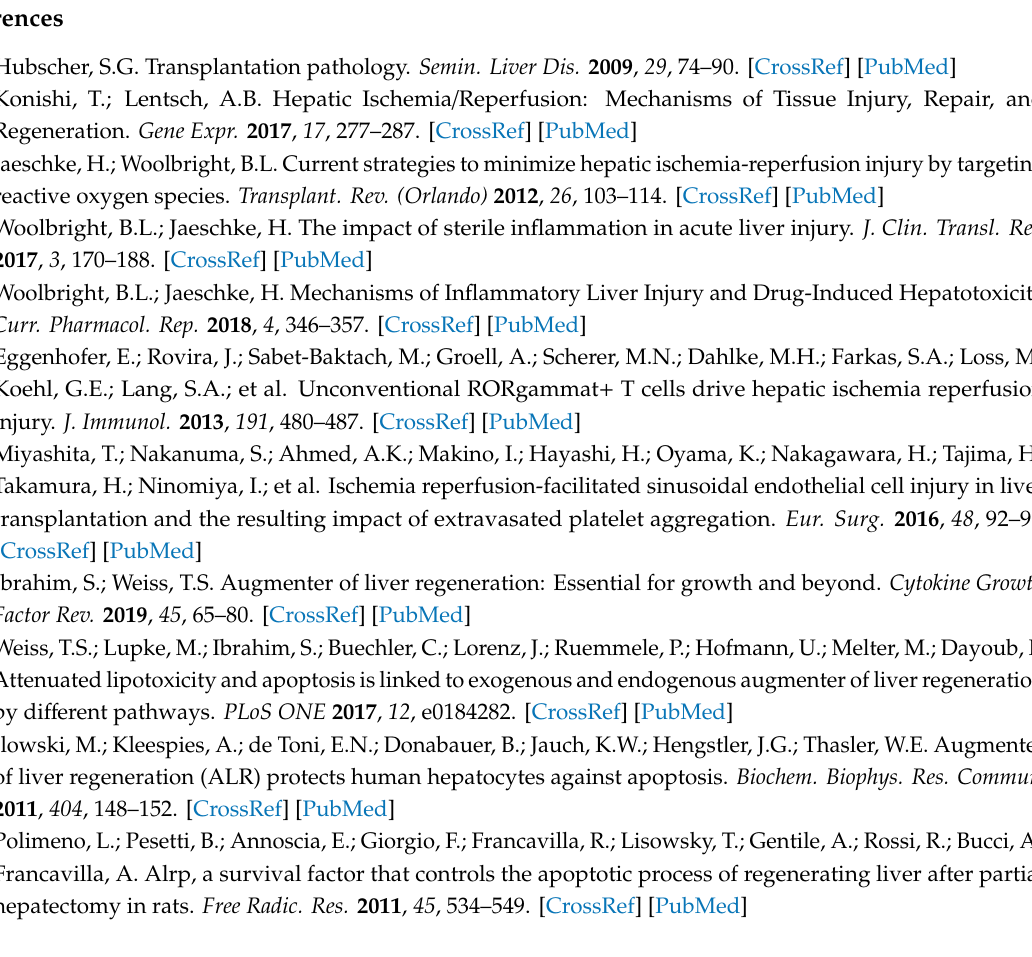
Table S2: Antibodies used in the study, Table S3: Primers for